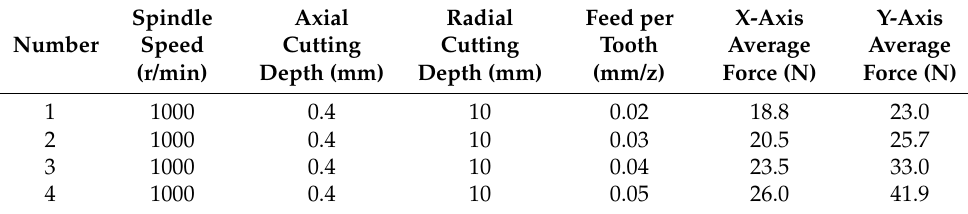
Table 2. The milling force coefficient experiment data tables.